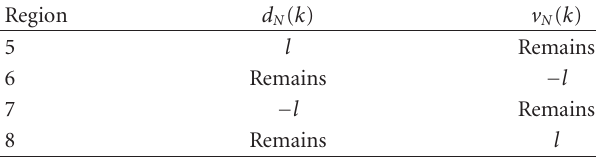
Table 3: Attributes of d N ( k ) and v N ( k